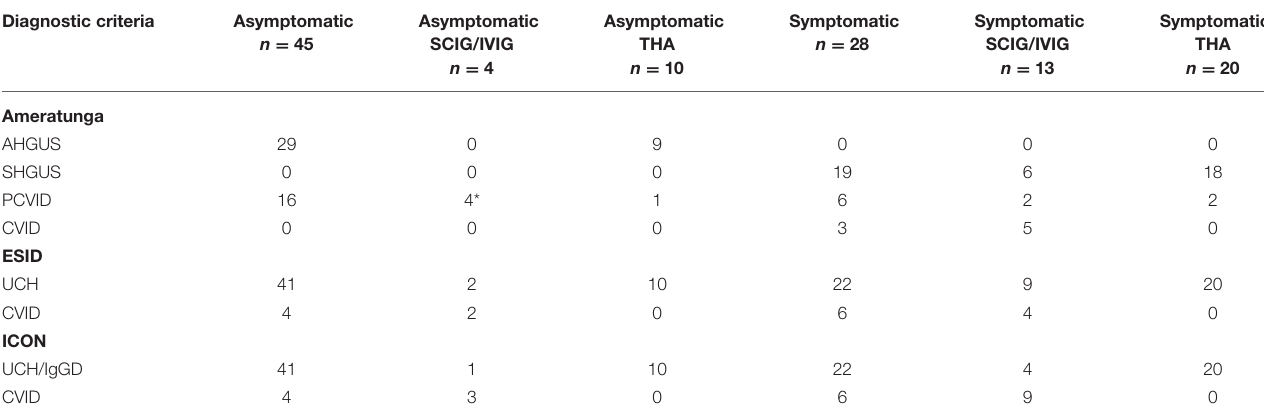
TABLE 3 | Retrospective application of three commonly used criteria for CVID. Diagnostic